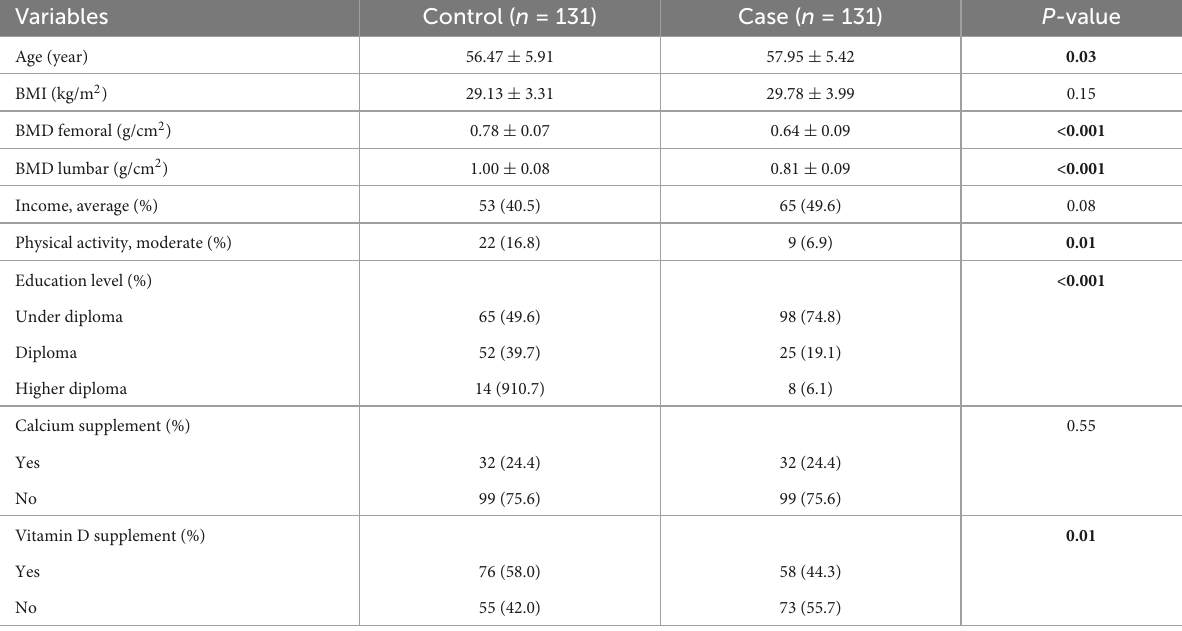
TABLE 1 Baseline characteristics of the study